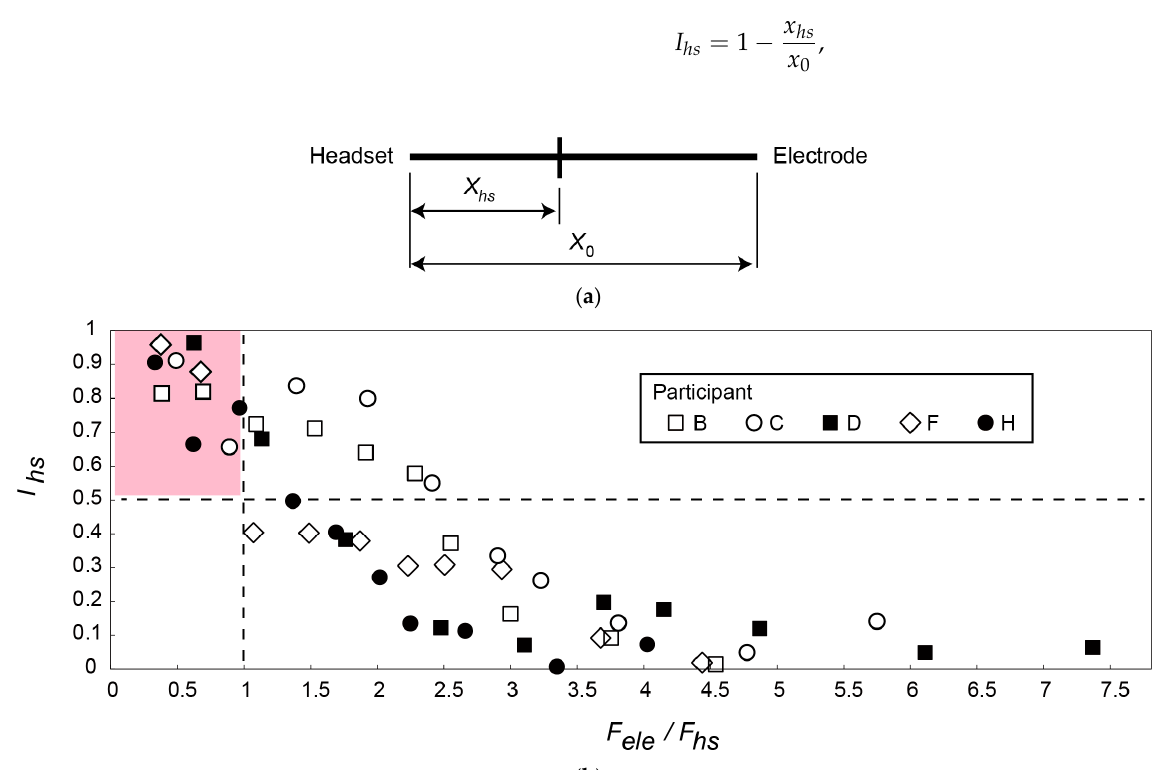
Figure 6. ( a ) Scale used to assess discomfort ratio. When the participants perceived pressure only from the ear pads, they made a check at the left edge. ( b ) Relationship between F ele / F hs and headset discomfort I hs . Each participant tested ten springs. When F ele / F hs < 1, I hs was larger than 0.5 for all participants (i.e., they perceived the pressure applied by the ear pads to be higher than that applied by the electrodes).